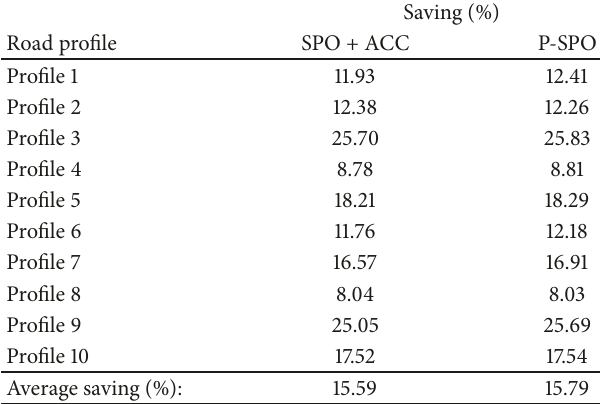
Table 1: The normalized fuel savings obtained in the simulations for a homogeneous platoon of two 30 tonne HDVs over all the road profiles. The middle column shows the fuel savings obtained with SPO+ACC, whereas the right-most column shows the fuel savings obtained with P-SPO. The normalization was carried out with respect to the baseline case, i.e., CC+ACC where the lead vehicle drives at the constant speed of 80 km/h and the intervehicle distance is set to the allowed